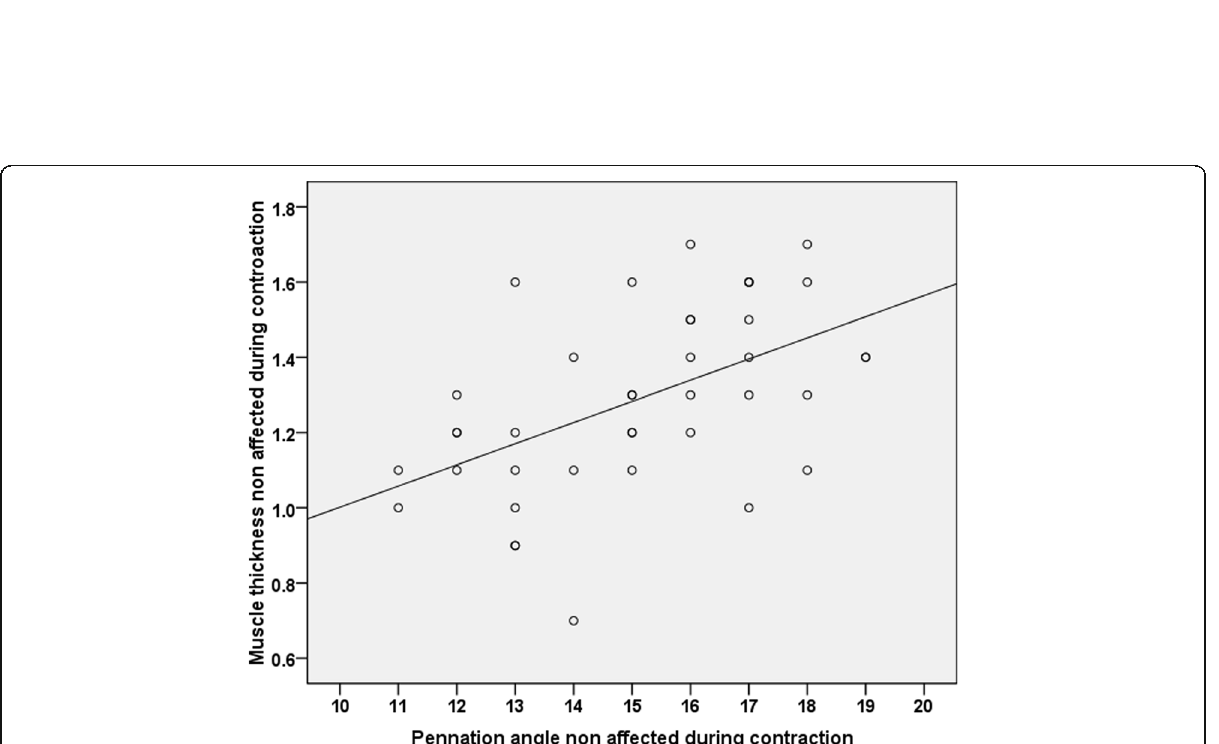
Fig. 6 Correlation between muscle thickness in the nonaffected side during contraction and pennation angle in the nonaffected side during contraction ( r = 0.523; P =